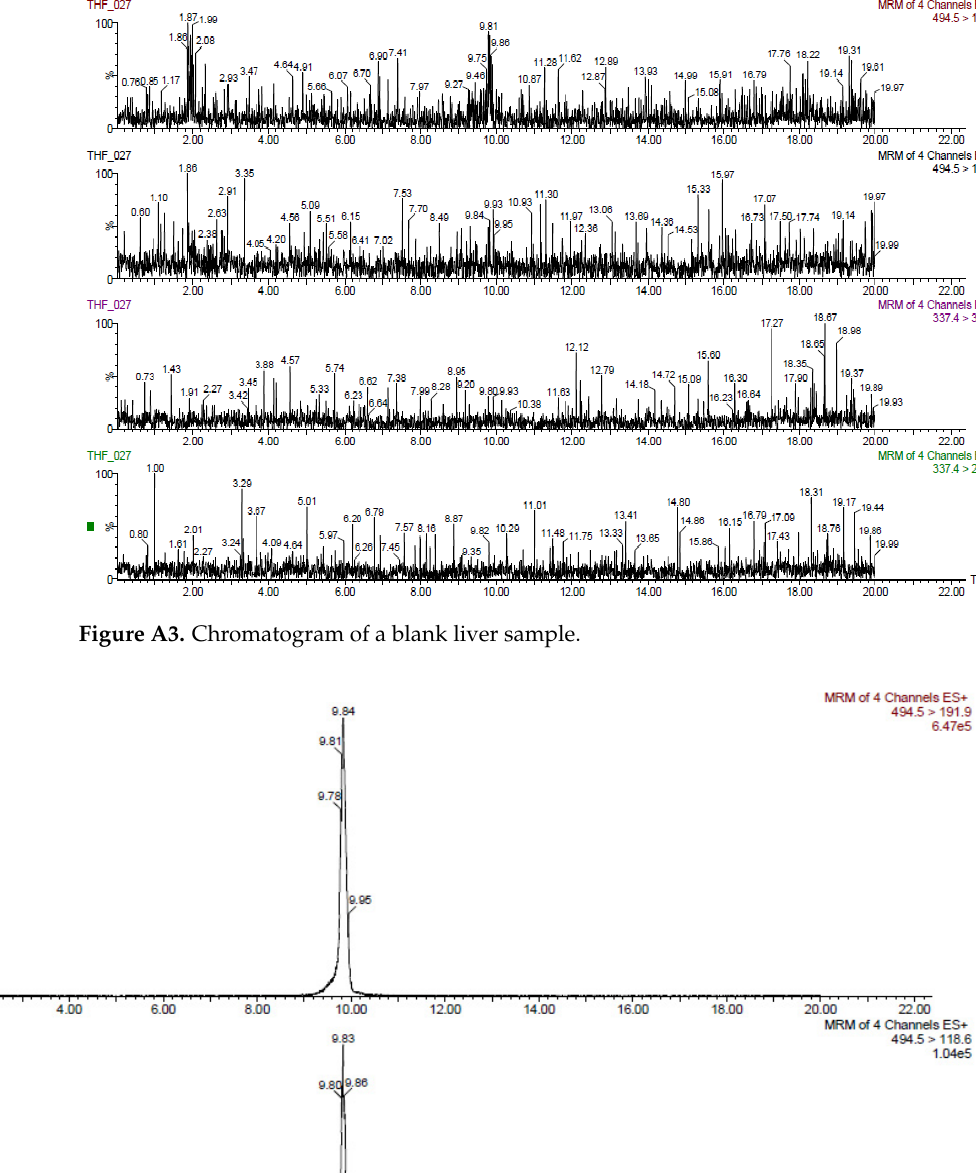
Figure A2. Chromatogram of a liver sample fortified with tiamulin at a level of 25 μ g/kg.